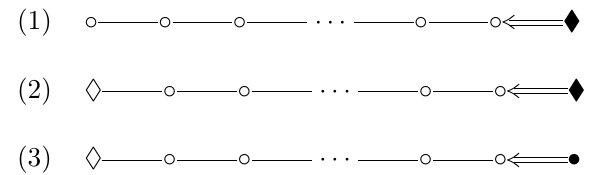
Figure 1 . The diagrams of the three Klein geometries D ( a ) m (cid:17) G m ( R ) =H ( a ) m , a = 1 ; 2 ; 3. The nodes are decorated by a color (white vs. black) and a shape (circle vs. lozenge). Forgetting all decorations we recover the Dynkin graph of C m +1 which speci(cid:12)es the underlying complex Lie group G m ( C ). Forgetting the shape of the nodes, one gets the Vogan diagram [60] of the real Lie algebra g m of the group G m ( R ). Forgetting the color, one gets the diagrams [61] of the complex parabolic subgroups P ( a ) m (cid:26) G m ( C ), while forgetting nothing one gets those of the reductive subgroup H ( a ) m (cid:24) = U(1) # (cid:2) L ( a ) m (cid:26) G m ( R ) where # is the total number of lozenges (black and white) and L ( a ) m is